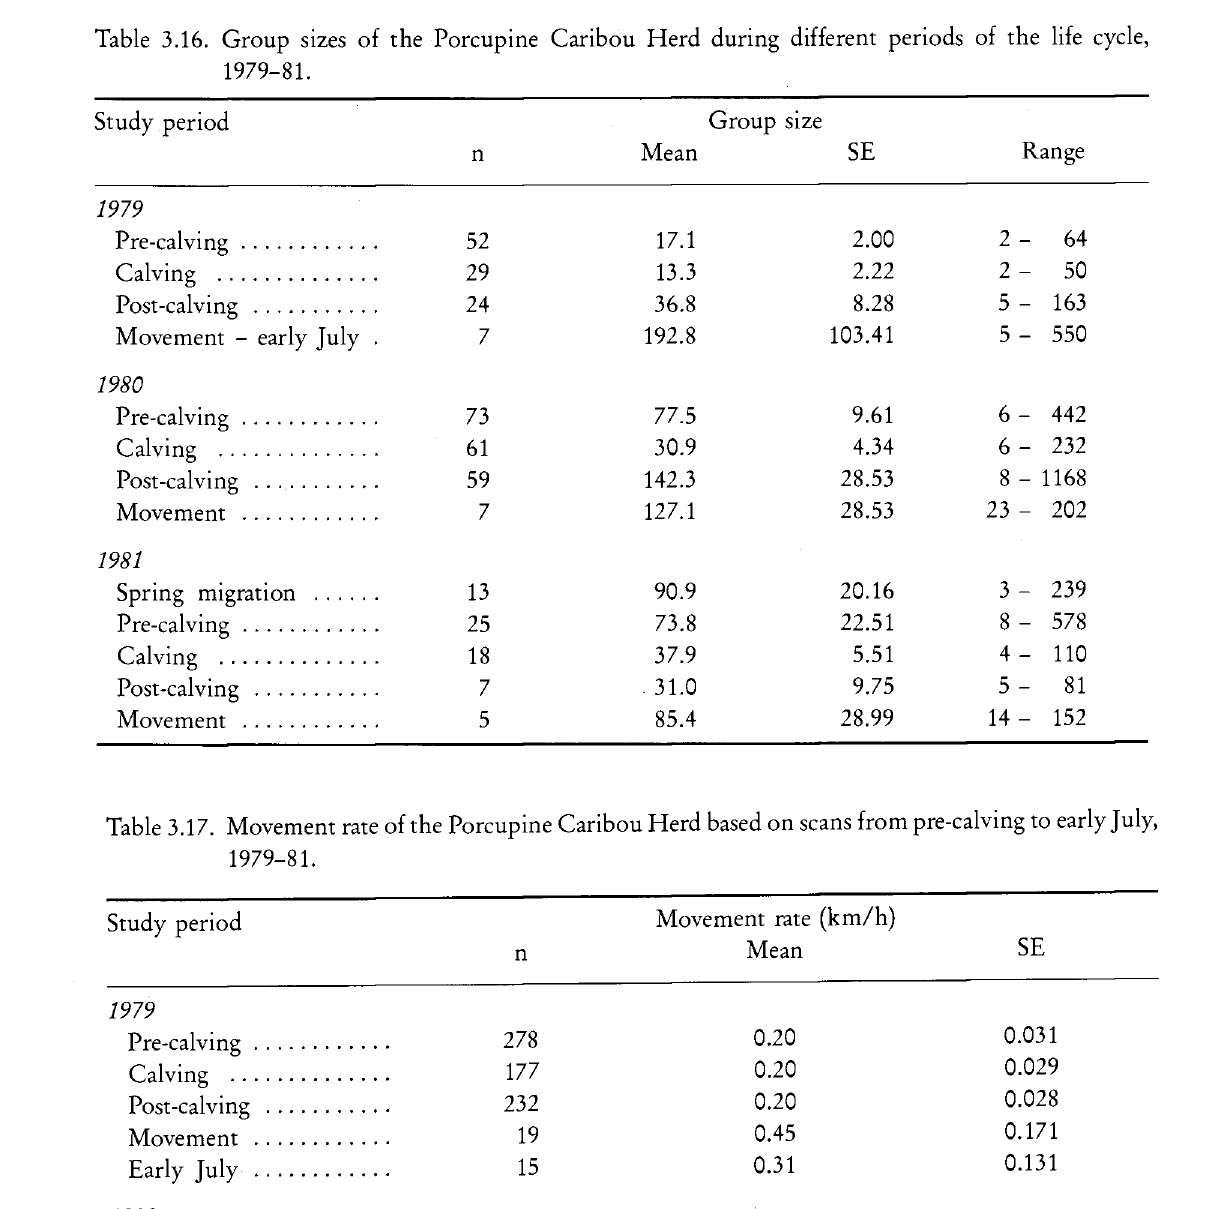
Table 3.16. Group sizes of the Porcupine Caribou Herd during different periods of the life cycle, 1979-81.